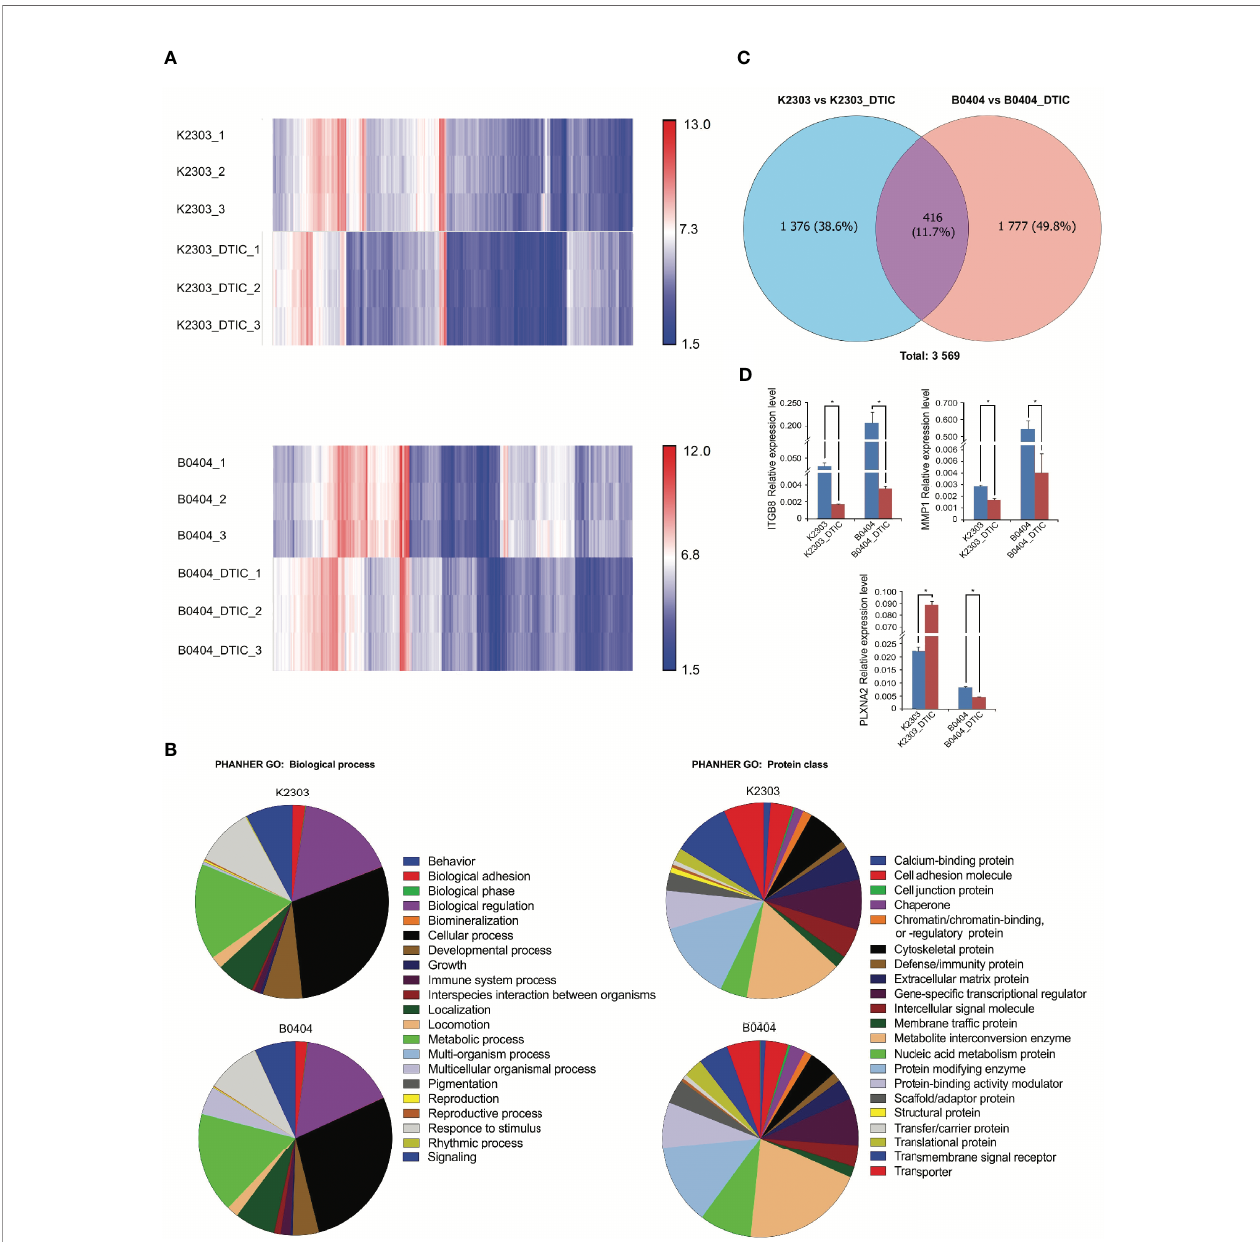
FIGURE 4 | Results of whole transcriptome analysis of K2303 and B0404 melanoma cells. (A) Heatmaps showing differentially altered transcripts in K2303 and B0404 melanoma cells after DTIC treatment. (B) Gene Ontology annotations for the two sub-trees, representing the biological process and protein class, for genes with dysregulated expression after exposure to DTIC in K2303 and B0404 melanoma cells. Plots were made using the PANTHER ™ v.16.0 classi fi cation system (http://www.pantherdb.org). (C) The Venn diagram shows the total number of altered transcripts in K2303 and B0404 melanoma cells after treatment with DTIC. (D) Changes in relative gene expression levels according to reverse transcription-quantitative polymerase chain reaction in K2303 and B0404 melanoma cells after 5.5 mM DTIC treatment. Data are presented as the mean±SEM. *P<0.05 by Mann-Whitney U test for unpaired samples. DTIC,